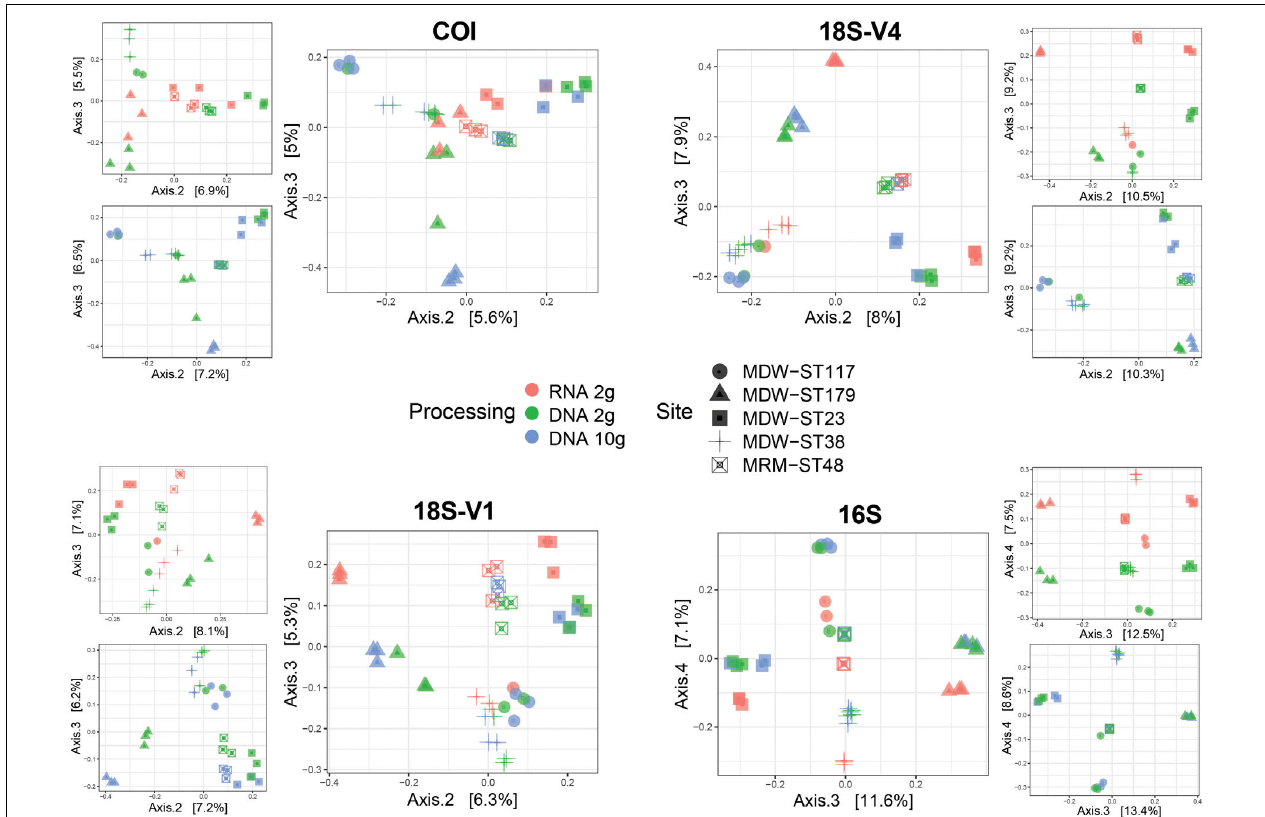
FIGURE 3 | Principal coordinates analysis (PCoA) ordinations showing community differences between RNA and DNA molecular processing methods using either RNA/DNA extracted jointly from ∼ 2 g of sediment (RNA 2 g/DNA 2 g) or DNA extracted from ∼ 10 g of sediment (DNA 10 g) in five deep-sea sites using four barcode markers targeting metazoans (COI, 18S-V1), micro-eukaryotes (18S-V4), and prokaryotes (16S). PCoAs were calculated using Jaccard dissimilarities for metazoans and Bray–Curtis dissimilarities for unicellular organisms. Inserts show pairwise